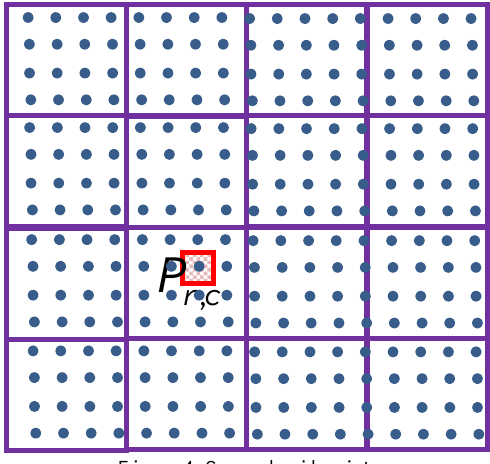
Figure 4. Ground grid